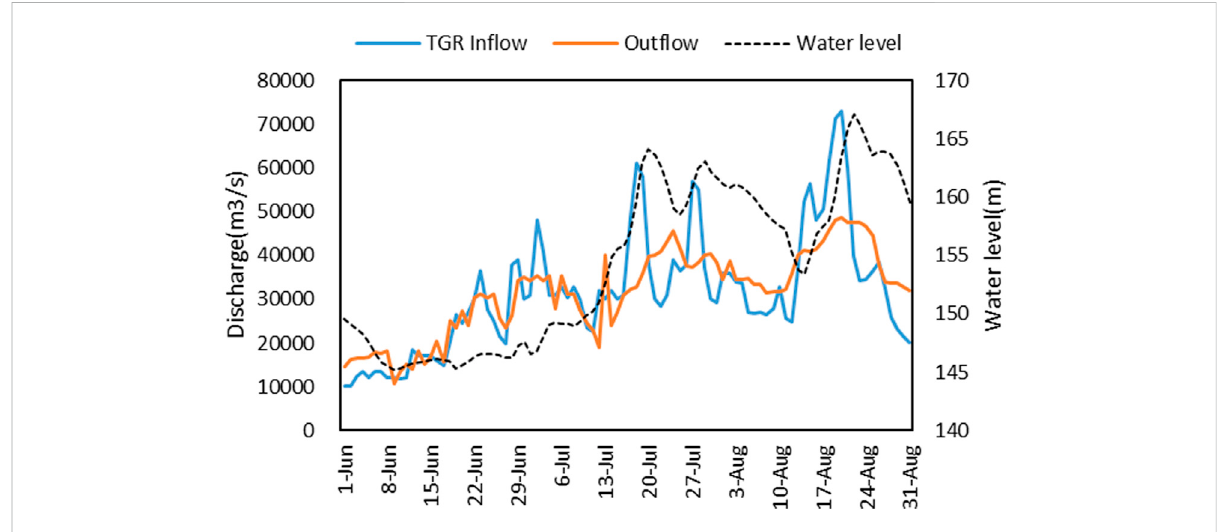
FIGURE 2 Three Gorges Reservoir in fl ow and downstream discharge, and stage upstream of the Three Gorges Dam during summer 2020.